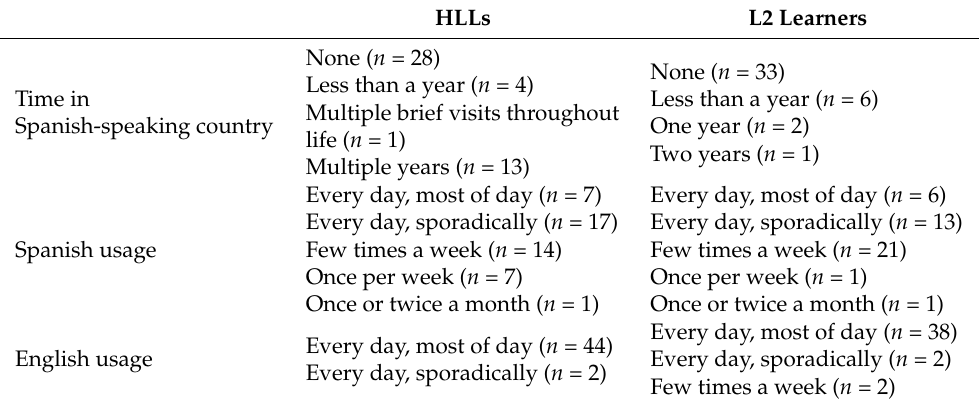
Table 1. Participant background